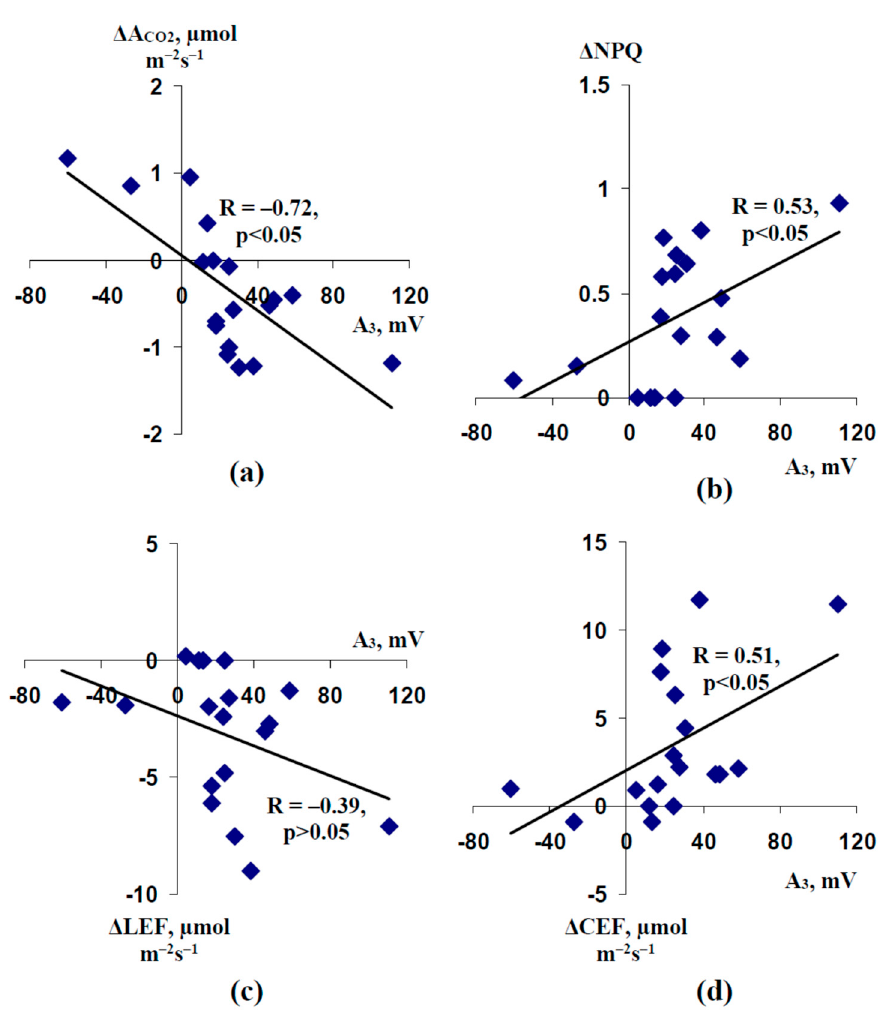
Figure 6. Dependences of burning-induced changes in photosynthetic CO 2 assimilation ( ∆ A CO2 ) ( a ), non-photochemical quenching ( ∆ NPQ) ( b ), photosynthetic linear electron flow ( ∆ LEF) ( c ), and cyclic electron flow around photosystem I ( ∆ CEF) ( d ) on amplitudes of electrical signals in the leaflet of the second mature leaf (A 3 ) in pea seedlings. Results of measurements in control pea seedlings, seedlings after 2 days of soil water shortage, and seedlings after 4 days of this shortage were analyzed together ( n = 18). It was assumed that negative amplitudes corresponded to the hyperpolarization signal. R is the linear correlation